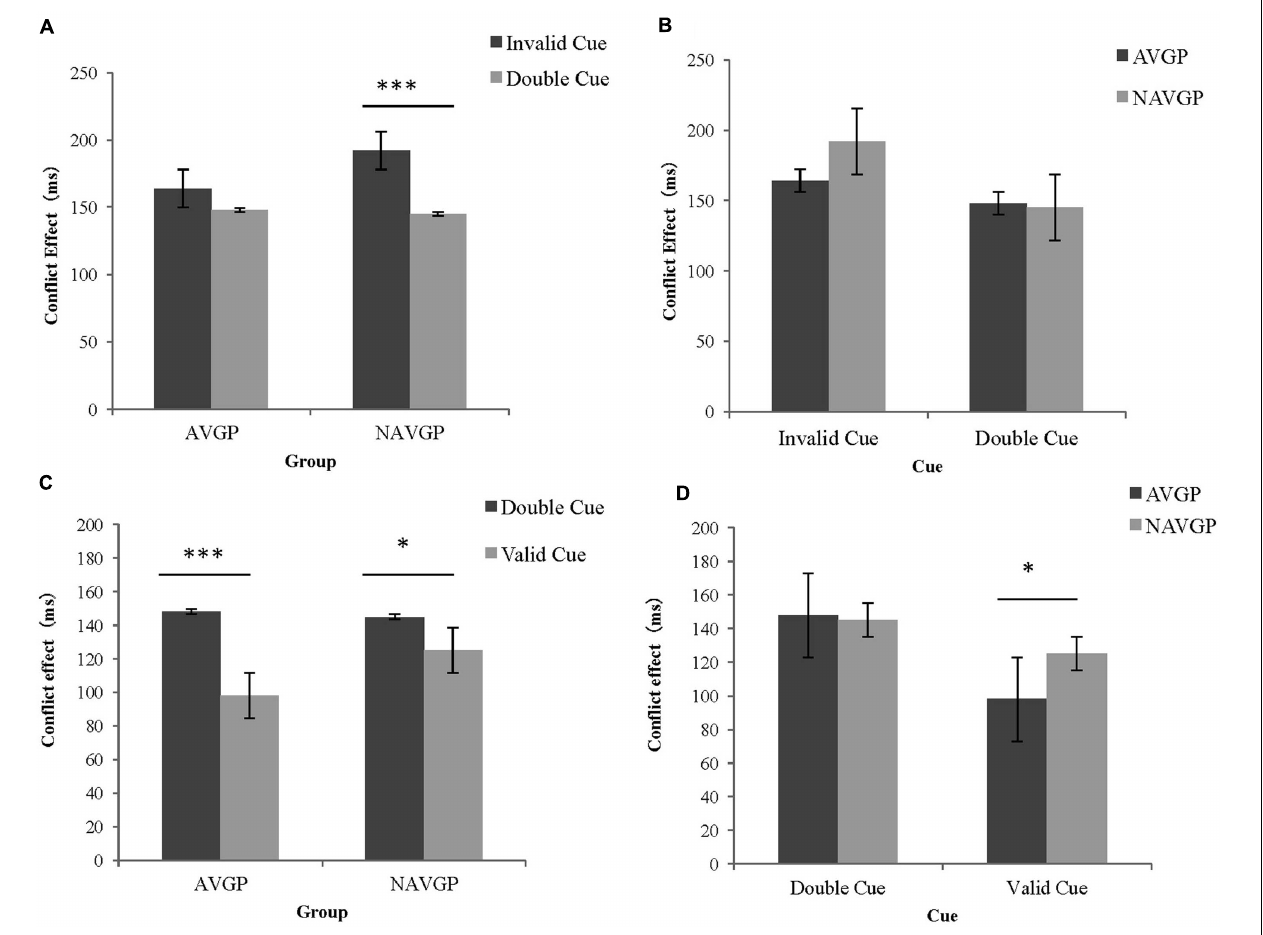
FIGURE 4 | Conflict effects of different groups under different cue conditions in the ANT-V. (A) The conflict effects in AVGPs and NAVGPs under invalid cues and double cues; (B) The conflict effects in AVGPs and NAVGPs under invalid cues and double cues; (C) The conflict effects of AVGPs and NAVGPs under double cues and valid cues; (D) The conflict effects of AVGPs and NAVGPs under double cues and valid cues. Error bars represent the standard error of the mean. ∗ p < 0.05, ∗∗∗ p <